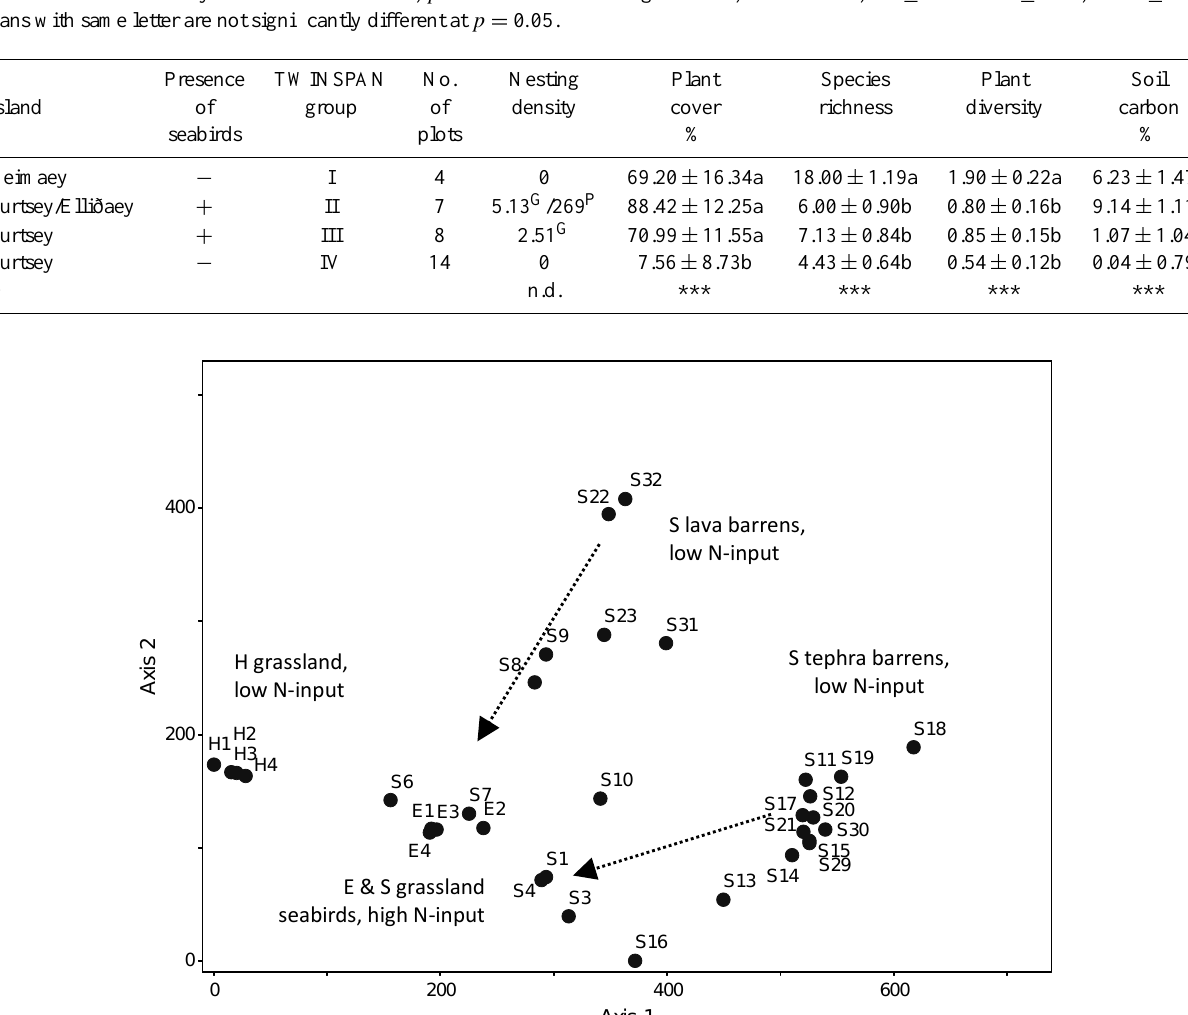
Figure 8. DCA-ordination results for permanent plots sampled on Surtsey (S), Heimaey (H) and Elliðaey (E) in 2012–2013. Arrows indicate direction of succession on Surtsey under nutrient inputs from breeding seagulls, axes units are multiplied by